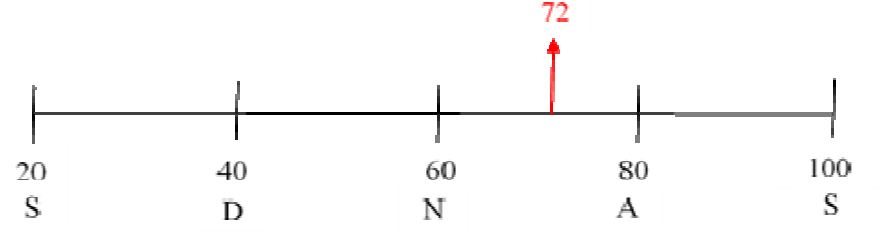
Figure 4: The score of Likert-scale questionnaire answered by the mid-proficiency